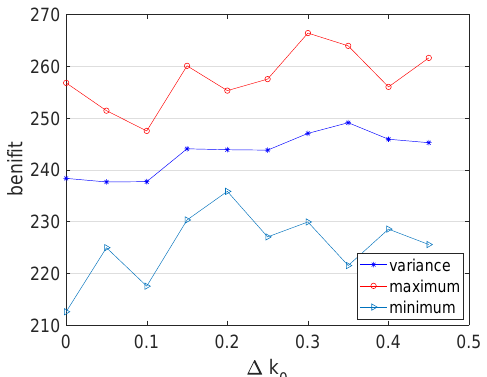
Figure 4. The changes in the total benefit with the increase in ∆ k 0 (a step of 0.05).